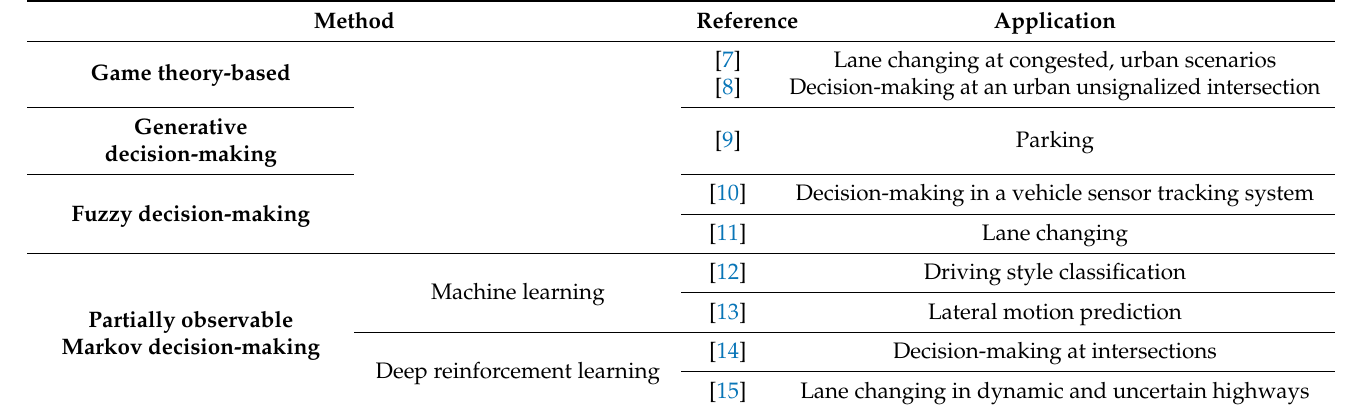
Table 1. Summary of the common decision-making